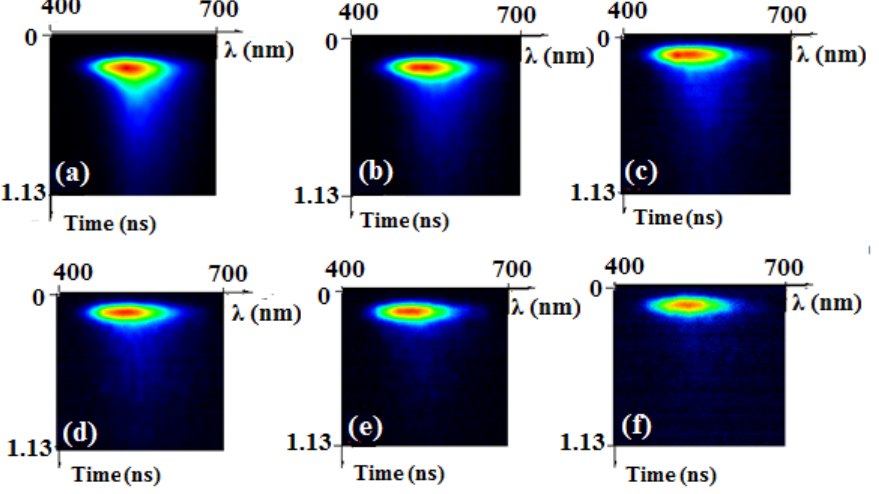
Figure 11. Contour plot of transient PL for PVK-HTs functionalized with different SWCNT concentrations: ( a ) 0%, ( b ) 1.87%, ( c ) 7.5%, ( d ) 15%, ( e ) 30%, and ( f ) 60%.